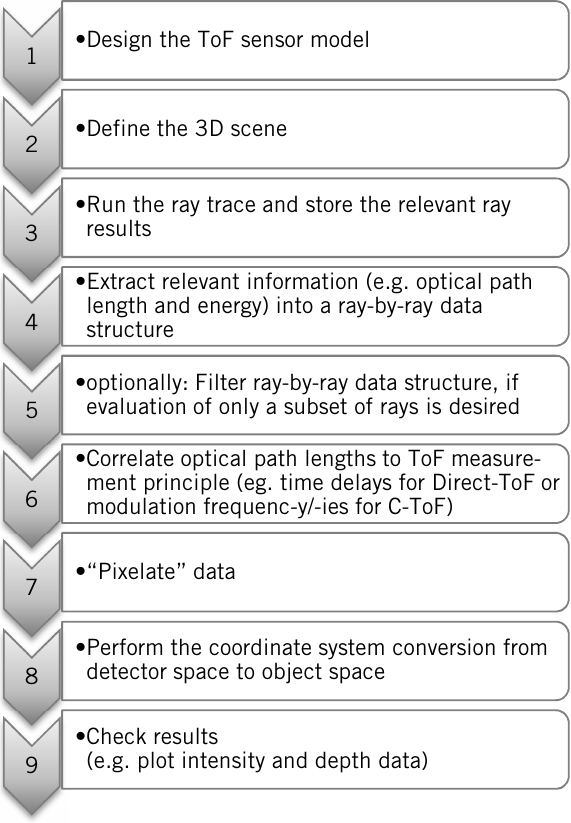
Figure 3. Flowchart of the simulation procedure of the Time-of- Flight sensor